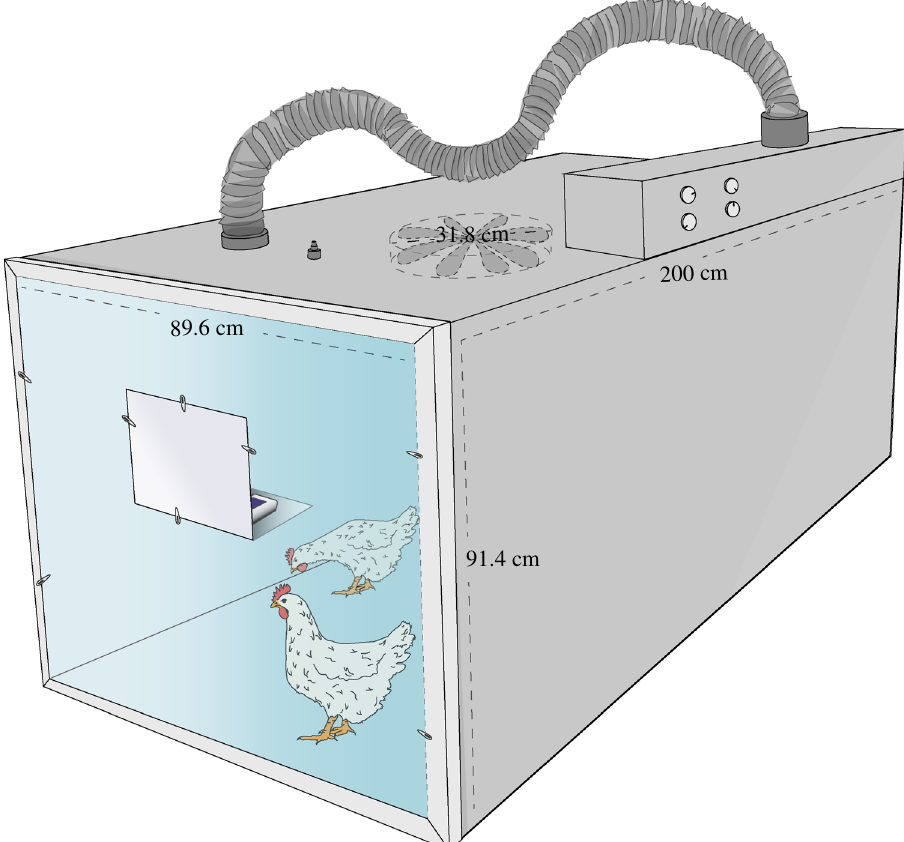
Figure 2. Aerosol chamber. Illustration of the aerosol-chamber utilised for inoculation. Internal measurements were 91.4 × 89.6 × 200 cm, a fan with a diameter of 31.8 cm was located in close proximity to the centre of the chamber, and an inlet-system for aerosols and an outlet system with an inbuilt HEPA-filter were part of the construction. The chamber was constructed in hard plastic (14 mm) except from one end consisting of a plexiglass-gate, hereby allowing continuous monitoring of animals within the chamber. A hatch was created in the plexiglass gate, in close proximity to an internal shelf used for the AeroCollect air-samplers and, when animals were kept within the chamber, a datalogger for temperature and air